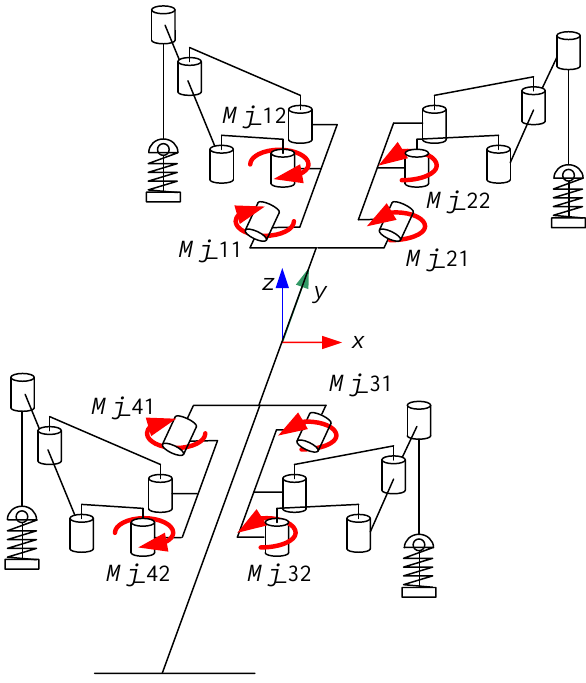
Figure 1. Mechanism of the gecko-like robot. Table 1. Main parameters of the gecko-like robot.